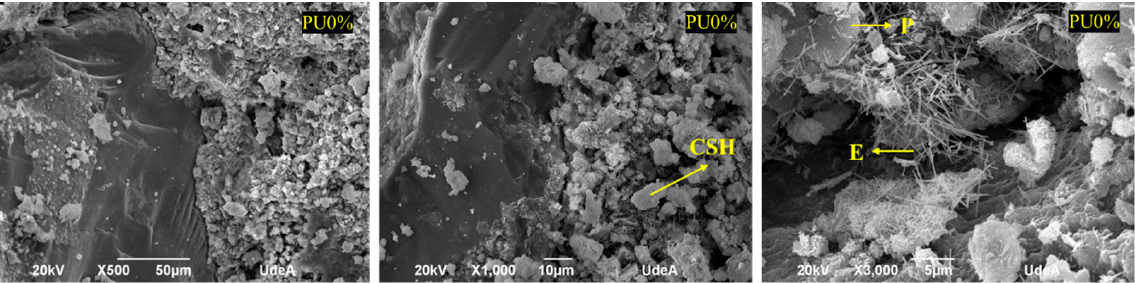
Figure 8. SEM analysis of mortar control PU0% .